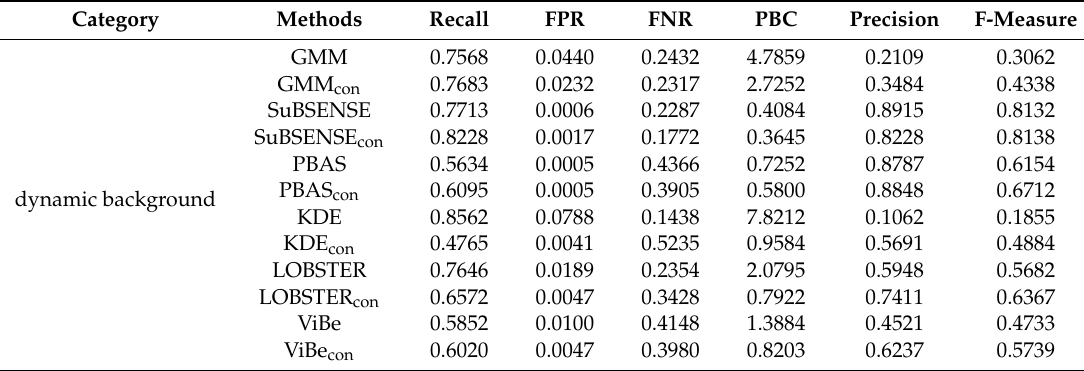
Table 4. Comparisons between BGS and BGS con by the proposed method.